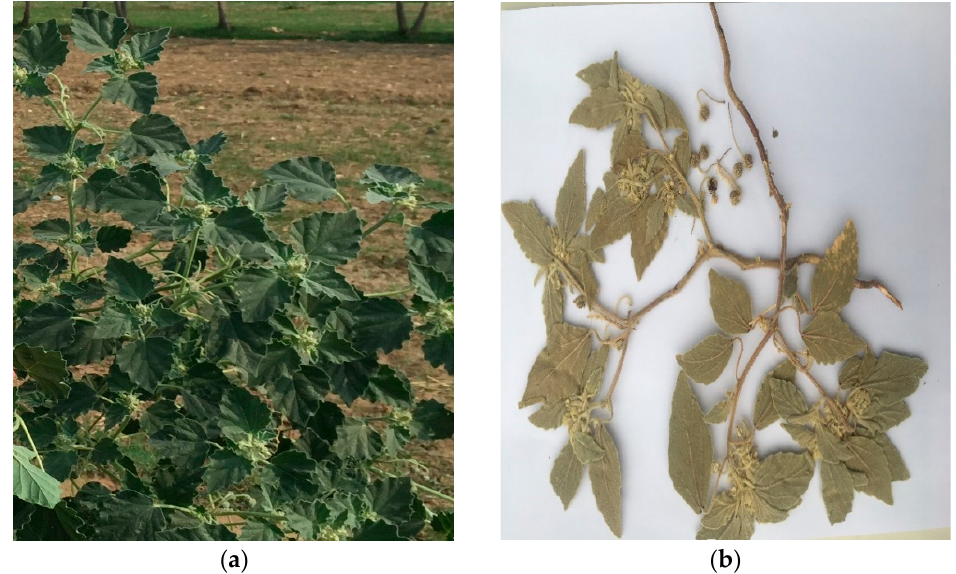
Figure 1. Chrozophora tinctoria plant growing in the natural environment ( a ) and dried form ( b ).